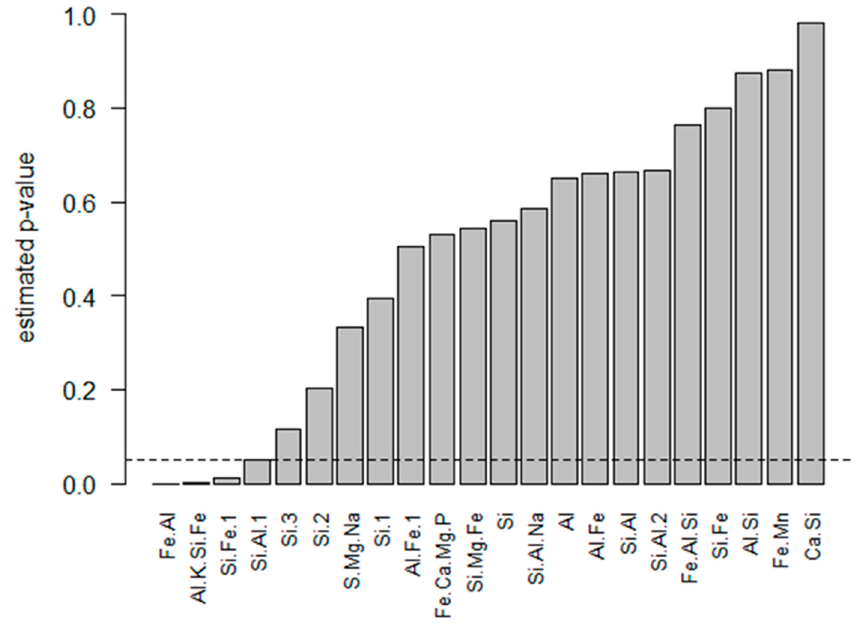
Figure 10. Bootstrap estimated p -values for the lasso coefficients, dotted line represents a p -value of 0.05.